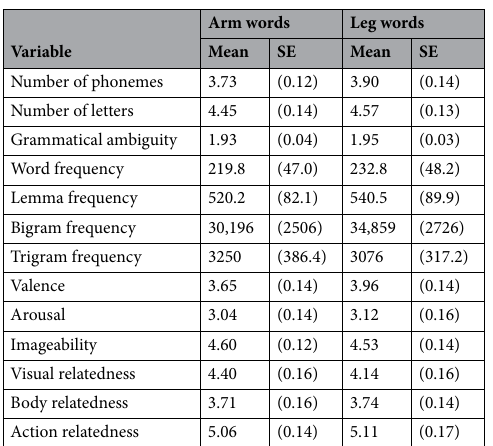
Table 1. Means and standard errors of psycholinguistic and semantic properties for arm and leg